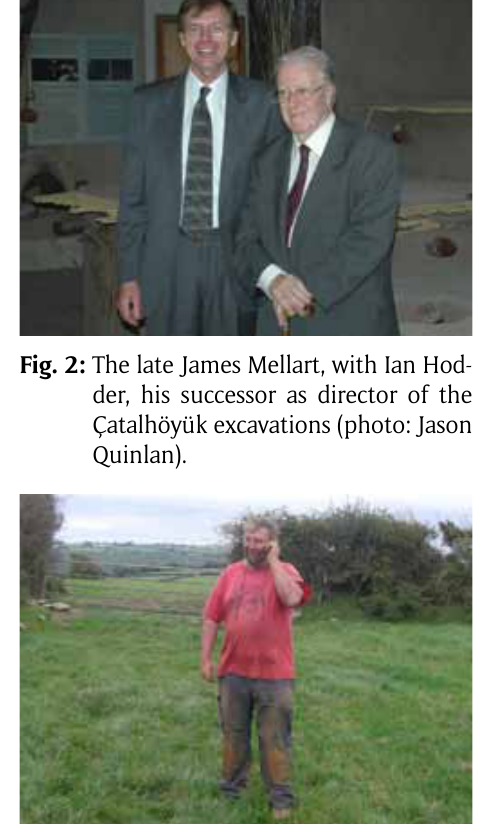
Fig. 3: Mike Parker Pearson (Professor of British Later